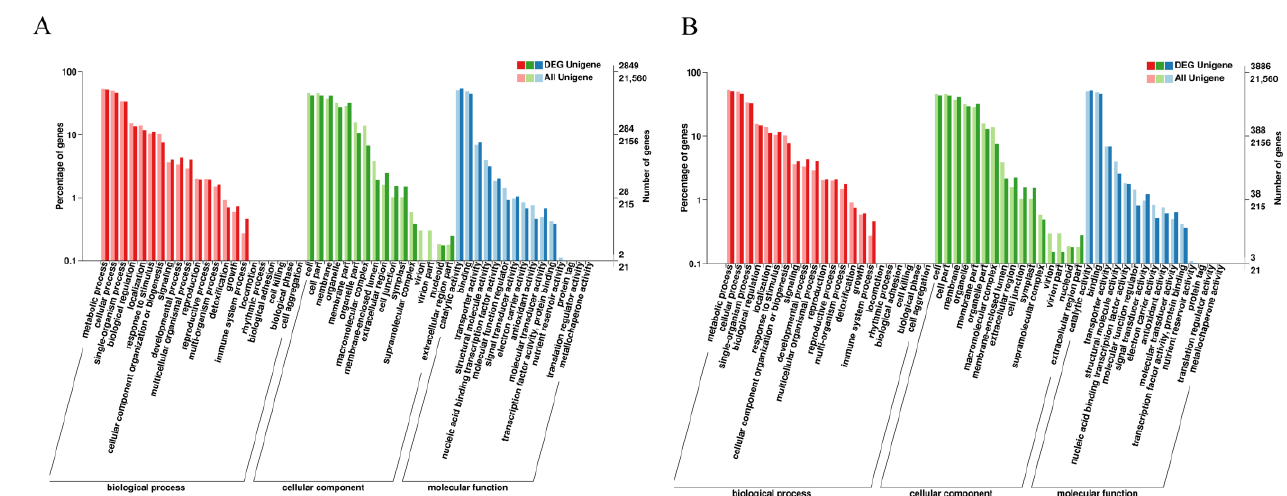
Figure 2. GO classification of DEGs from WP110 vs. TP110 and WX110 vs. TX110. ( A ) GO classification of DEG unigenes from WP110 vs. TP110. ( B ) GO classification of DEG unigenes from WX110 vs. TX110. The x -axis in ( A , B ) represents GO level-two terms belonging to three GO categories including biological process, cellular component, and molecular function. The y -axis in ( A , B ) represents the percentage and number of unigenes.